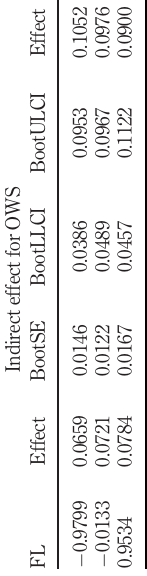
Table 4. Conditional